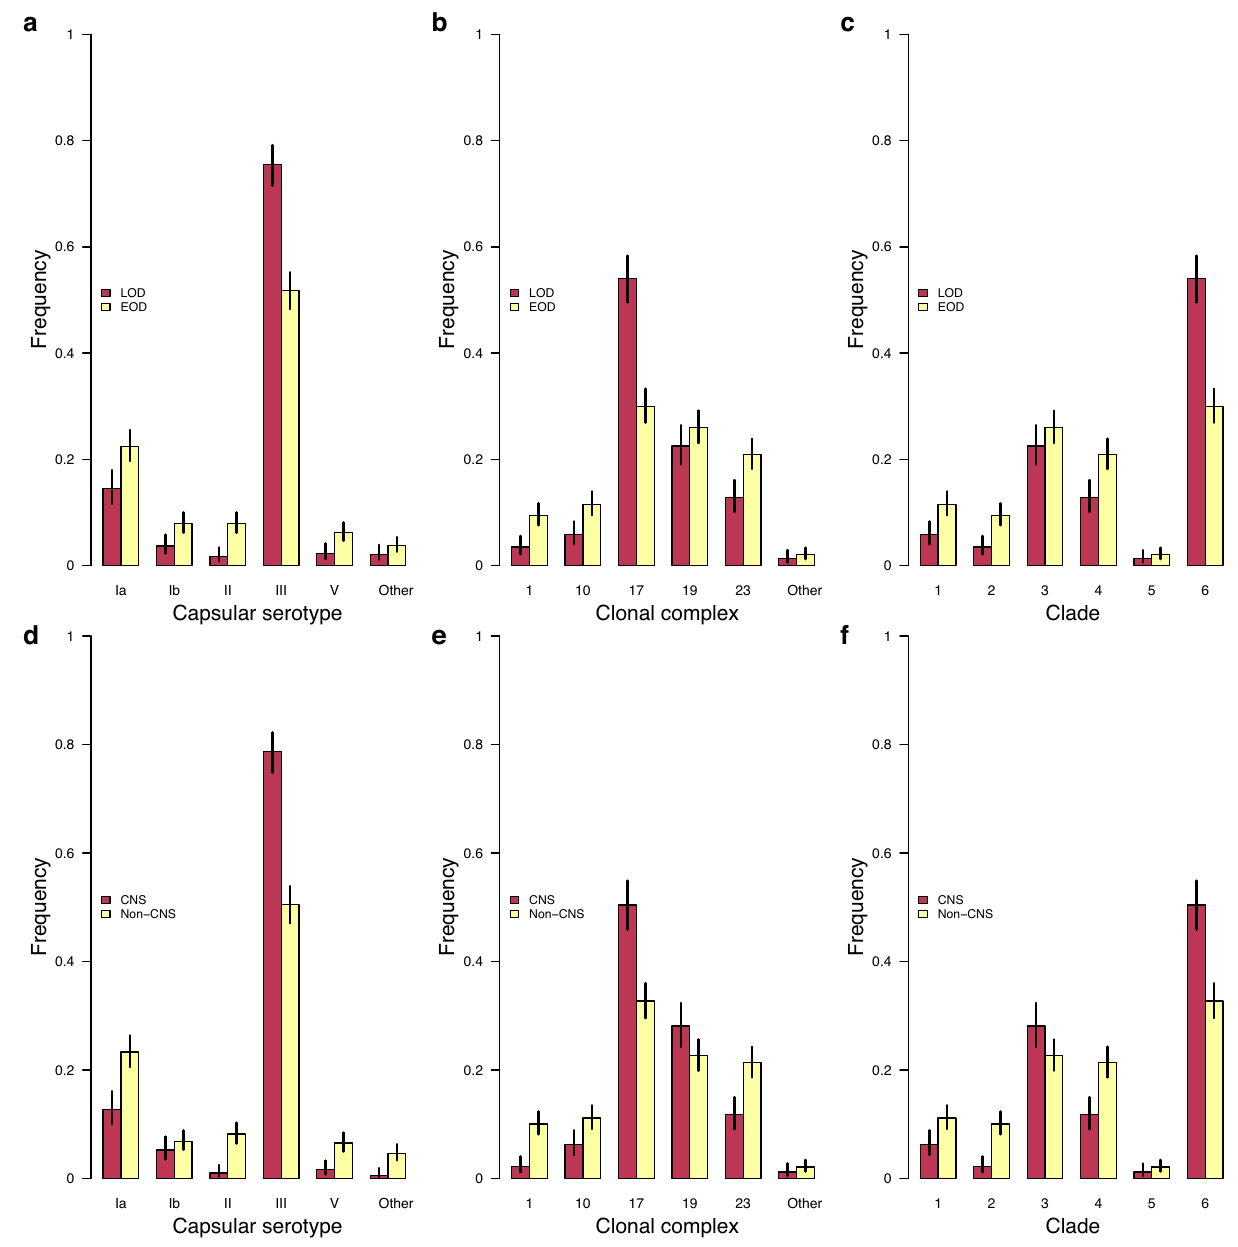
Fig. 3 Relative frequency of GBS strains strati fi ed by disease onset time and body isolation tissue. a Relative frequency of GBS capsular serotypes in LOD ( n = 515) and EOD ( n = 823) isolates. The statistical signi fi cance for each serotype based on the test of given proportions were as follows: Ia ( P = 0.0004), Ib ( P = 0.0017), II ( P = 4.47×10 − 07 ), III ( P = 2.07×10 − 18 ), V ( P = 0.0009), and Other ( P = 0.1082). b Relative frequency of GBS clonal complexes in LOD ( n = 515) and EOD ( n = 823) isolates. The statistical signi fi cance for each clonal complex based on the test of given proportions were as follows: 1 ( P = 2.75 × 10 − 05 ), 10 ( P = 0.0005), 17 ( P = 3.75 × 10 − 18 ), 19 ( P = 0.1710), 23 ( P = 0.0002), and Other ( P = 0.4024). c Relative frequency of GBS clades in LOD ( n = 515) and EOD ( n = 823) isolates. The statistical signi fi cance for each clade based on the test of given proportions were as follows: 1 ( P = 0.0005), 2 ( P = 2.75 × 10 − 05 ), 3 ( P = 0.1710), 4 ( P = 0.0002), 5 ( P = 0.4024), and 6 ( P = 3.75 × 10 − 18 ). d Relative frequency of GBS capsular serotypes in isolates sampled from the CNS ( n = 494) and non-CNS ( n = 844) tissues. The statistical signi fi cance for each serotype based on the test of given proportions were as follows: Ia ( P = 1.50 × 10 − 06 ), Ib ( P = 0.2932), II ( P = 1.32 × 10 − 09 ), III ( P = 1.75 × 10 − 25 ), V ( P = 2.23 × 10 − 05 ), and Other ( P = 1.22 × 10 − 05 ). e Relative frequency of GBS capsular serotypes in isolates sampled from the CNS ( n = 494) and non-CNS ( n = 844) tissues. The statistical signi fi cance for each serotype based on the test of given proportions were as follows: 1 ( P = 9.87 × 10 − 09 ), 10 ( P = 0.0034), 17 ( P = 2.23 × 10 − 10 ), 19 ( P = 0.0256), 23 ( P = 7.96 × 10 − 06 ), and Other ( P = 0.2874). f Relative frequency of GBS lineages in isolates sampled from the CNS ( n = 494) and non-CNS ( n = 844) tissues. The statistical signi fi cance for each serotype based on the test of given proportions were as follows: 1 ( P = 0.0034), 2 ( P = 9.87 × 10 − 09 ), 3 ( P = 0.0256), 4 ( P = 7.96 × 10 − 06 ), 5 ( P = 0.2874), and 6 ( P = 2.23 × 10 − 10 ). All the error bars in each plot represents 95% con fi dence intervals. Source data used to generate fi gures in panel a – f is available in Supplementary Data 3.